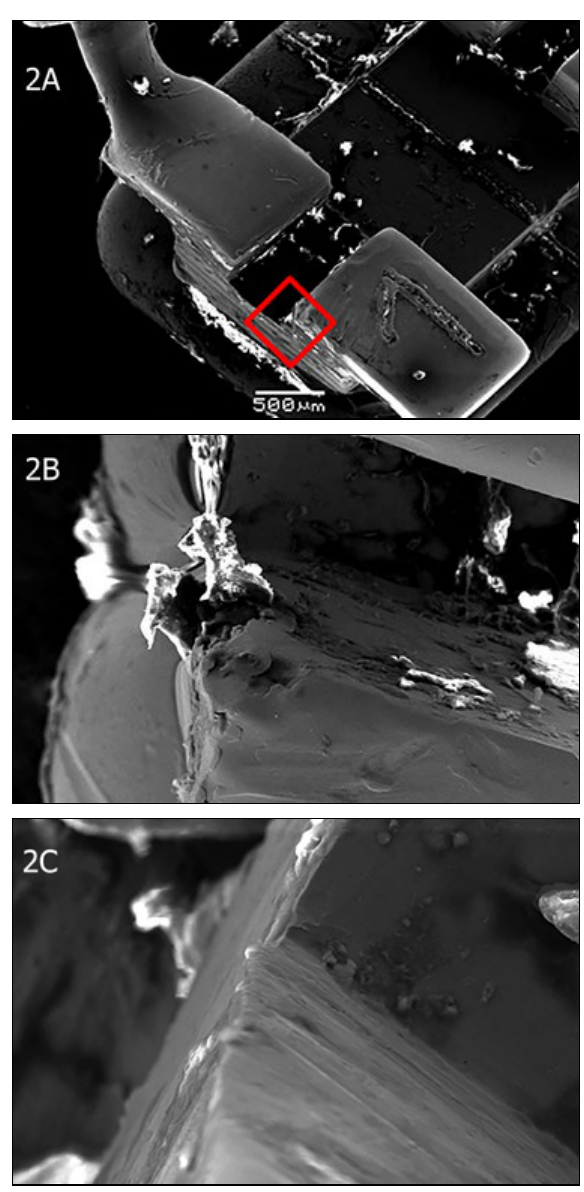
Figure 2. Representative topographic SEM micrographs of brackets’ surfaces after canine